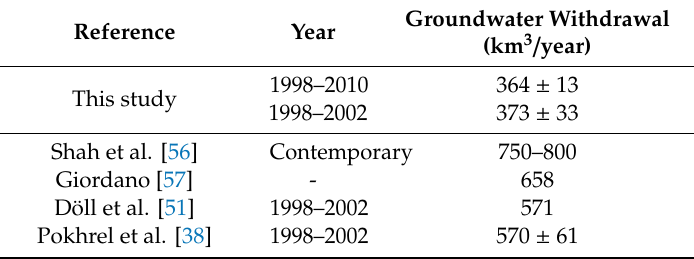
Table 3. Same as Table 2 but for groundwater